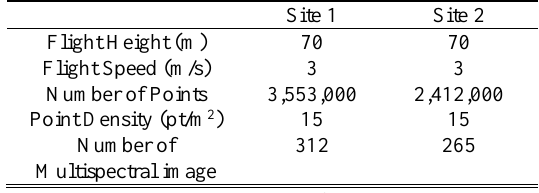
Table 2. Data specifications.